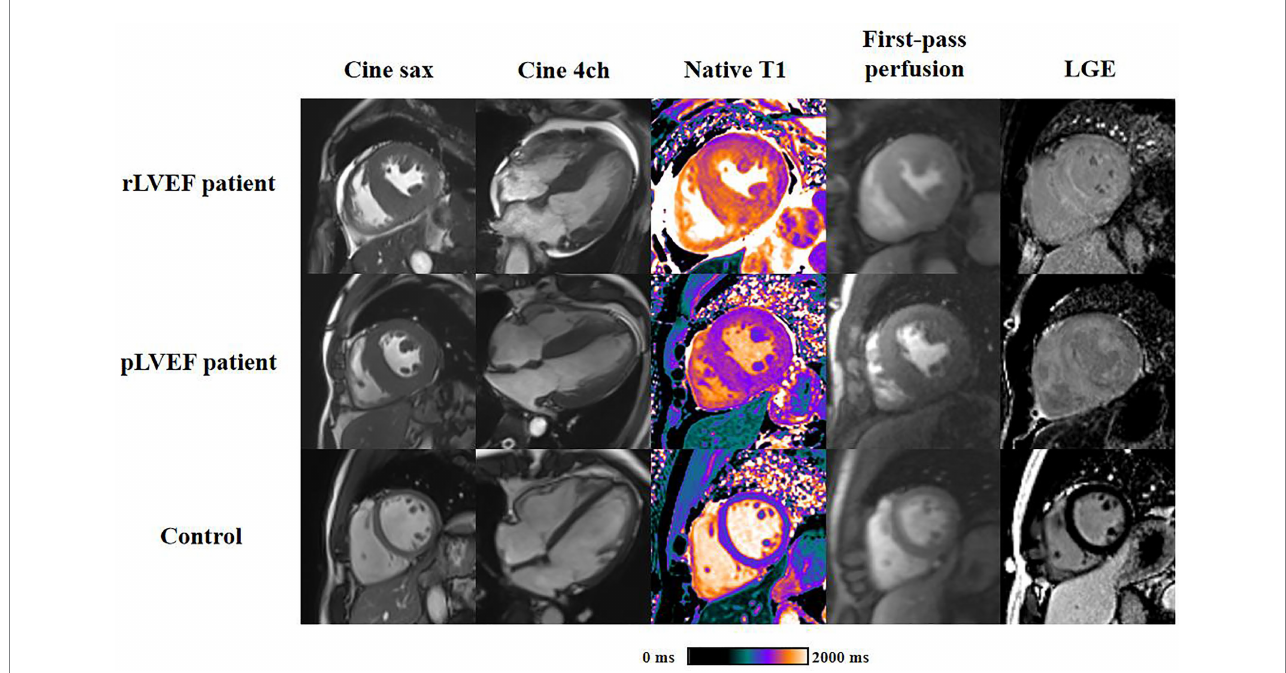
FIGURE 3 Representative cardiac magnetic resonance plots of rLVEF patient, pLVEF patient and control. Images from left to right are end-diastolic short-axis cine, end-diastolic 4-chamber cine, native T1 mapping, end-diastolic first-pass perfusion and late gadolinium enhancement, respectively. All short-axis images are acquired in middle segment. rLVEF, reduced left ventricular ejection fraction; pLVEF, preserved left ventricular ejection fraction; sax, short-axis; 4ch, 4-chamber; LGE, late gadolinium